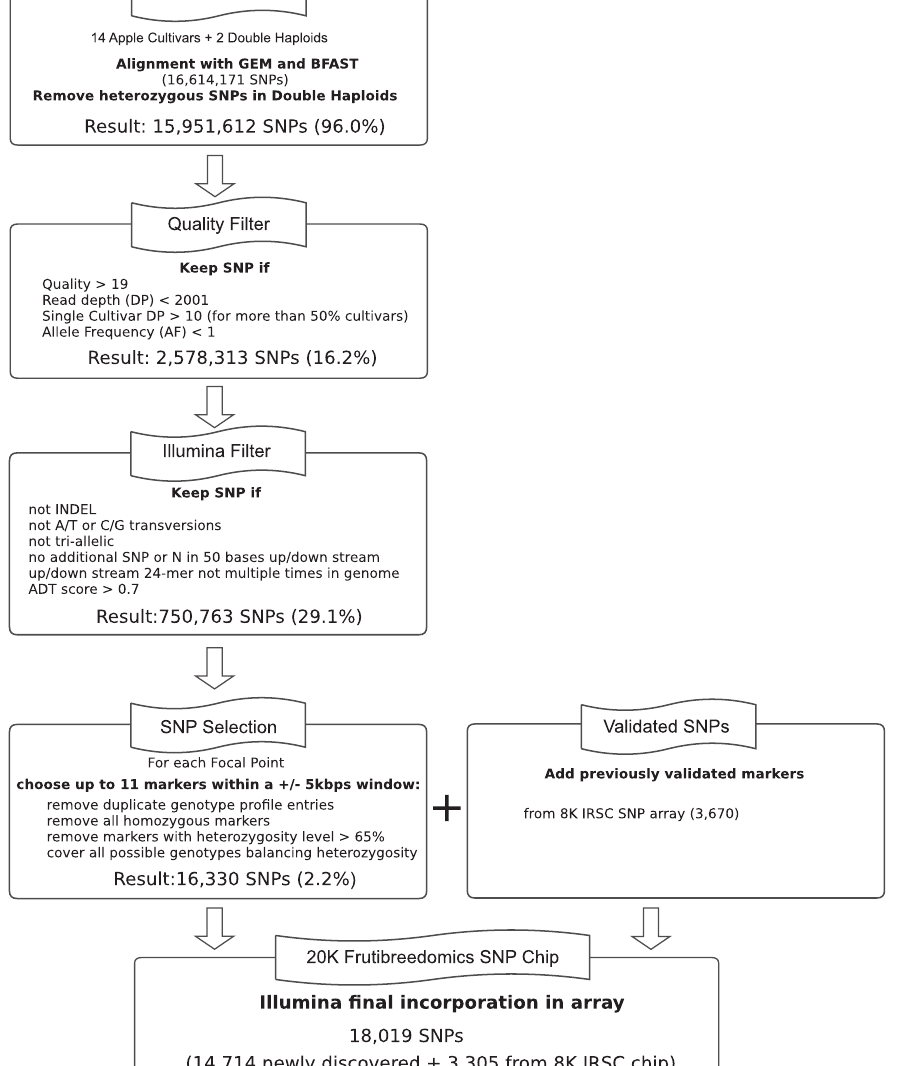
Figure 1. The SNP selection workflow. The SNP selection process was a cascade involving four steps: Detection, Quality Filtering, Illumina specific Filtering and SNP Selection, with the number of SNPs reduced after each step. The specific filtering criteria have been reported for each filtering stage, as well as the number of resulting SNPs, with the corresponding percentage survival, relative to the total number of SNP markers after the previous step. From the 20,000 selected, Illumina successfully incorporated a total of 18,019 SNP probes into the new array, 14,714 of which were newly discovered and 3,305 previously validated.